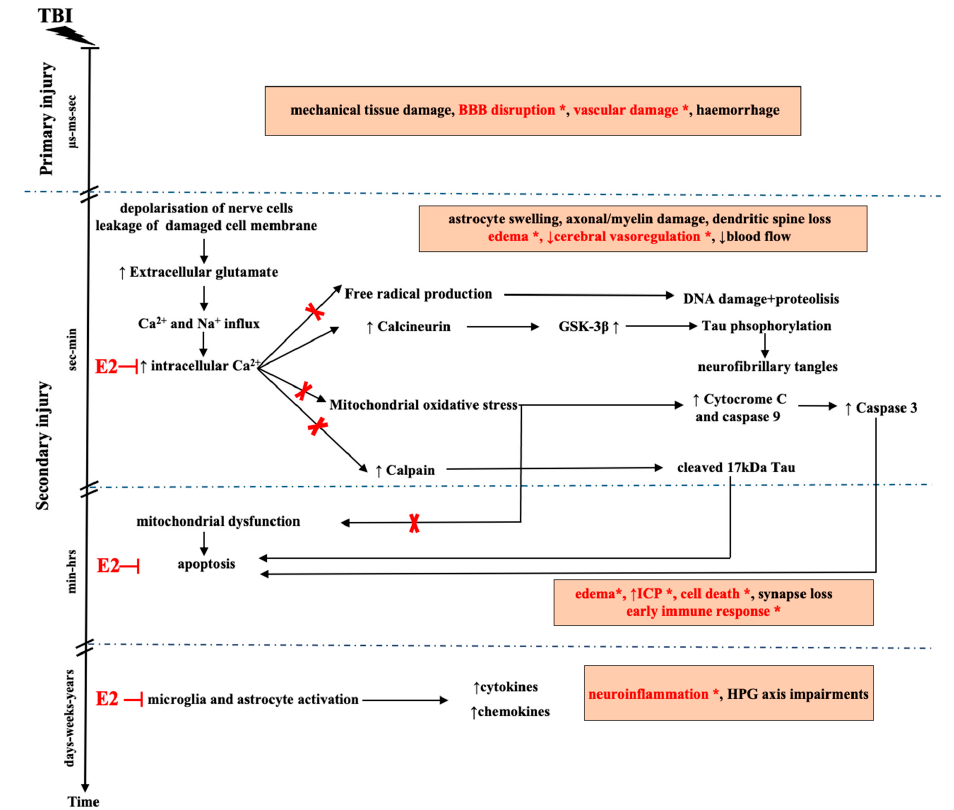
Figure 1. Timeline of events after the TBI and proposed neuroprotective effects of 17 β -estradiol (E2). Red “X” or horizontal “T” letter and “*” with red letters depict blocked or reduced processes in the TBI pathomechanism after E2 administration.